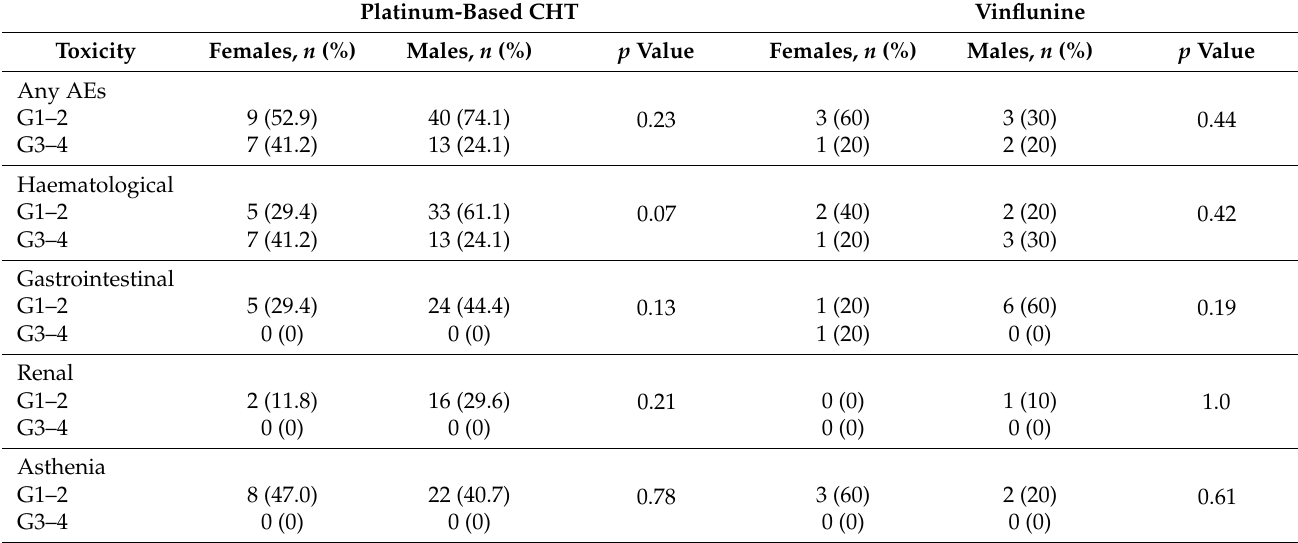
Table 4. Toxicity to treatment with platinum-based chemotherapy and vinflunine